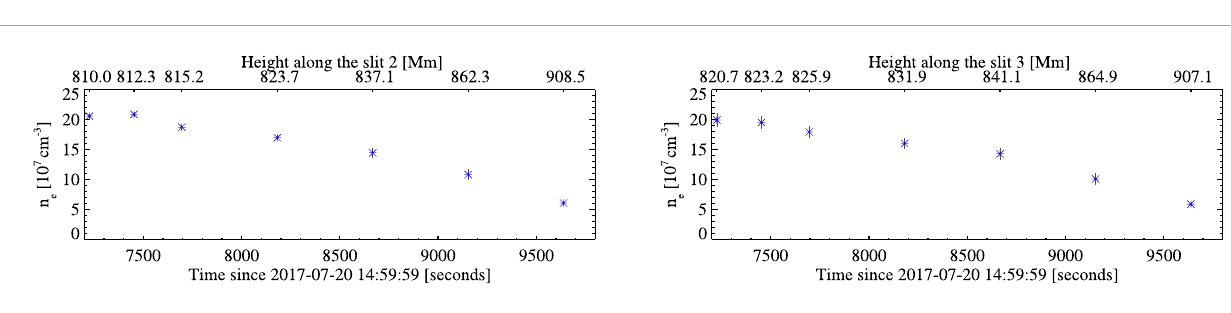
FIGURE 10 The evolution of electron density (n e ) of the CME core with height and time. The blue cross symbols show the variation of n e averaged over the spatial direction along the blue and the cyan curves shown in Figure 9 , and the dark grey bars are one sigma deviation in n e values.